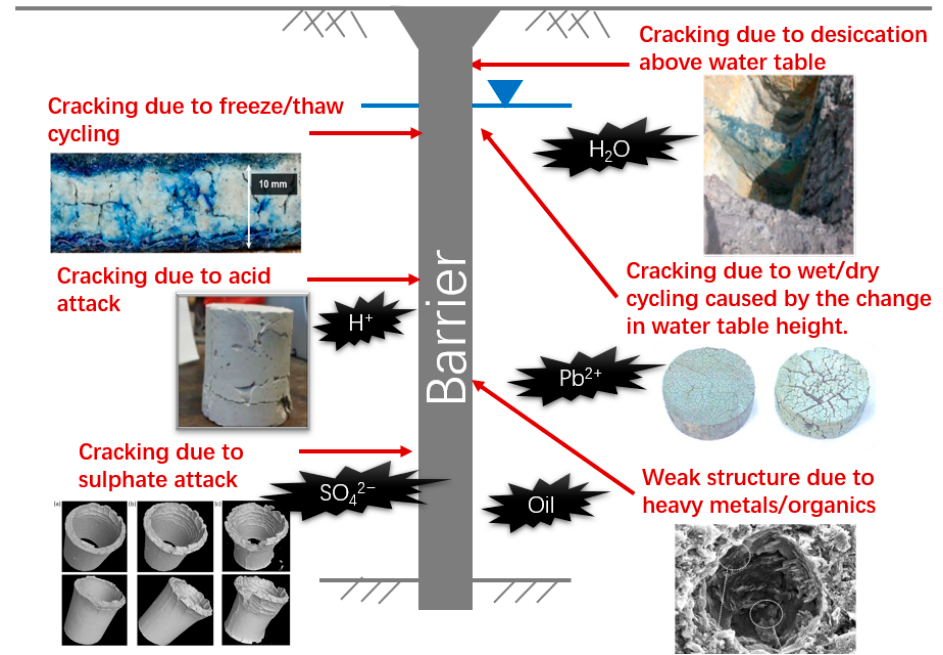
Figure 1. Cementitious barrier materials deteriorate under mechanical, chemical, and environmen- tal stresses.